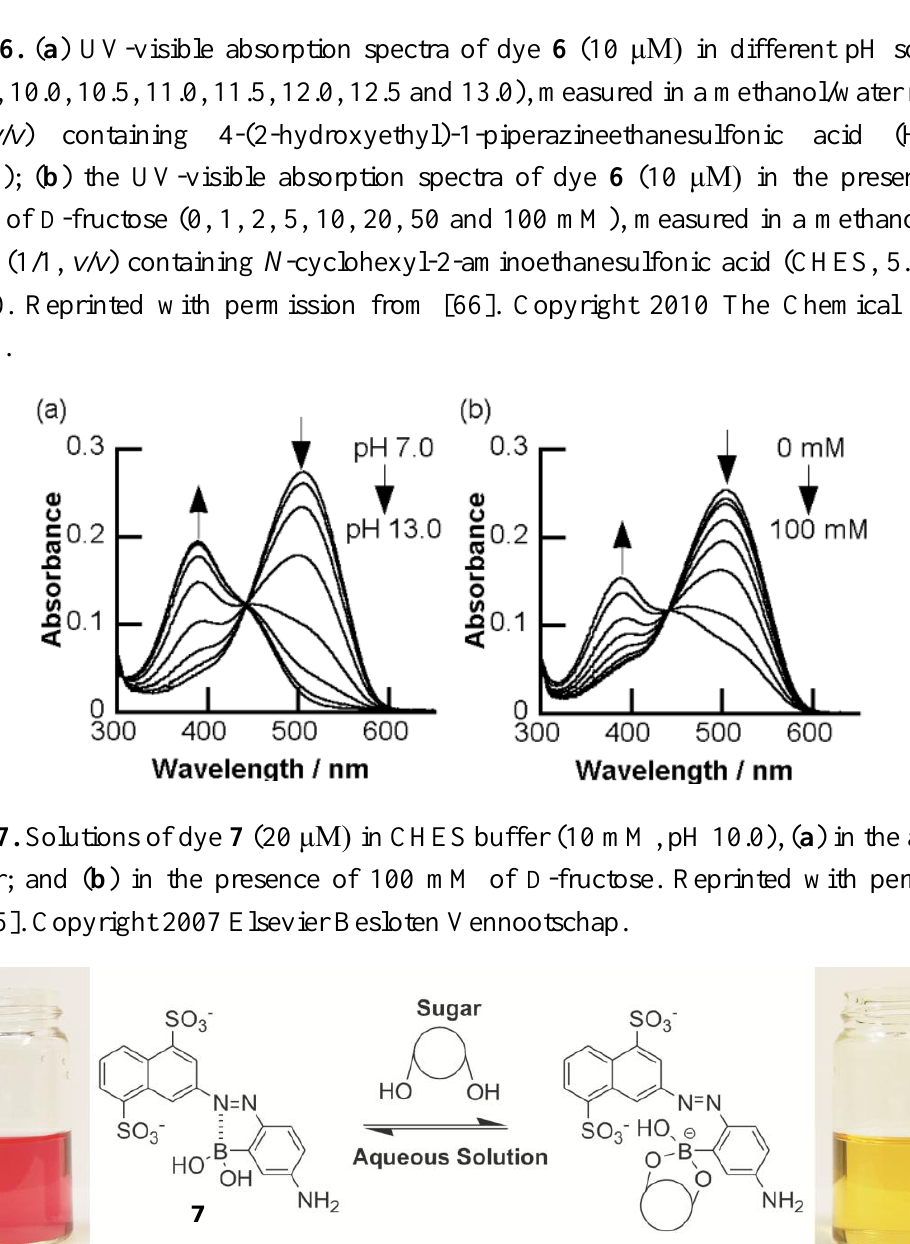
Figure 6. ( a ) UV-visible absorption spectra of dye 6 (10 μM) in different pH solutions (pH 7.0, 10.0, 10.5, 11.0, 11.5, 12.0, 12.5 and 13.0), measured in a methanol/water mixture